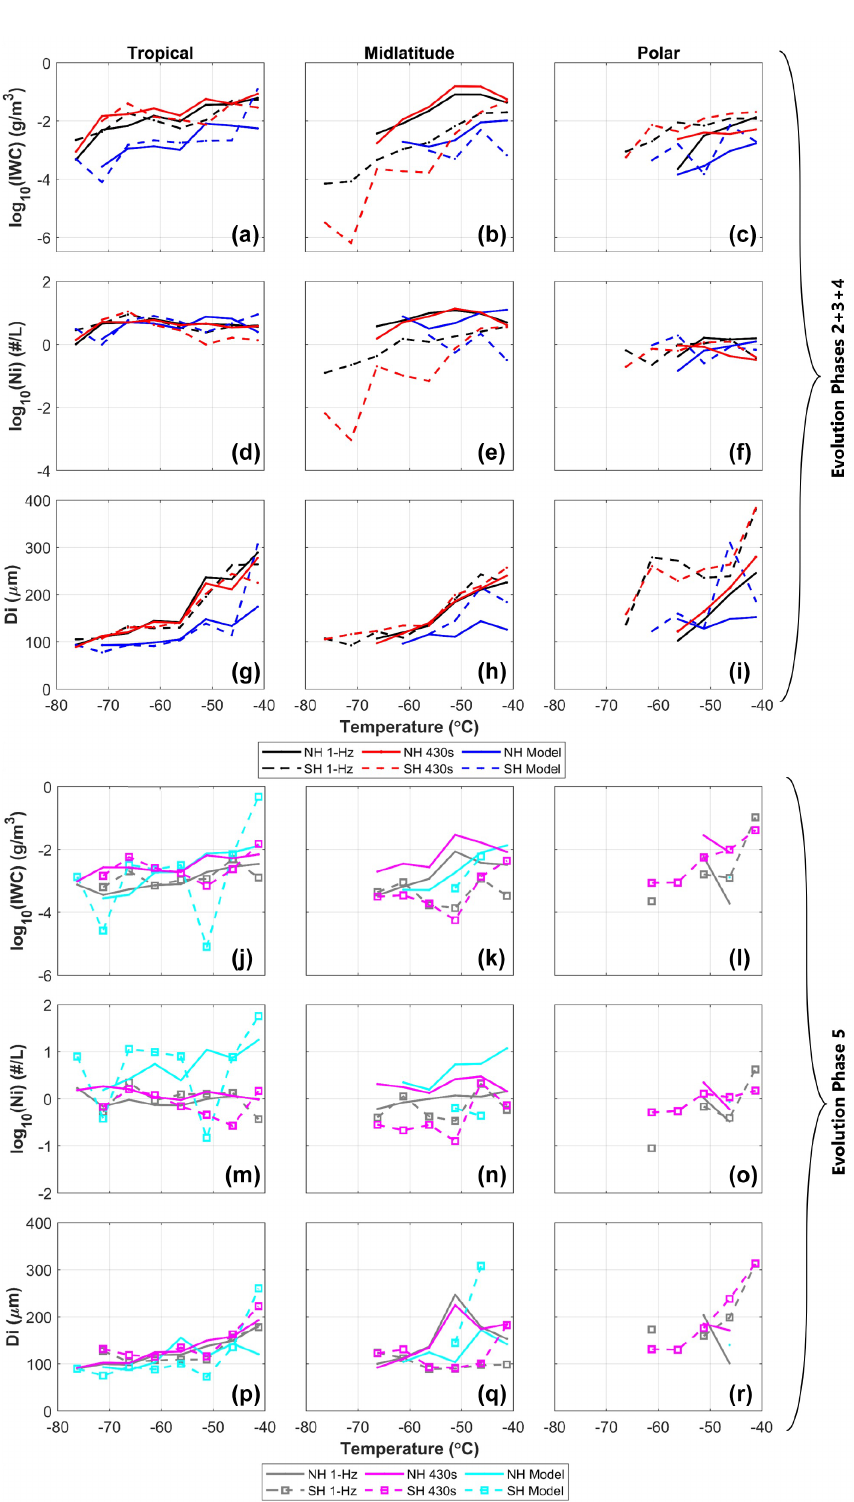
Figure 14. Averages of log 10 (IWC), log 10 (Ni) and Di for every 5 ◦ temperature bin for evolution phases 2 to 5, separated by NH and SH. The top three rows are for phases 2 + 3 + 4, while the bottom three rows are for phase 5 only. Columns 1, 2 and 3 represent tropical, midlatitudinal and polar regions, respectively. The number of samples is shown in the Supplement (Fig.